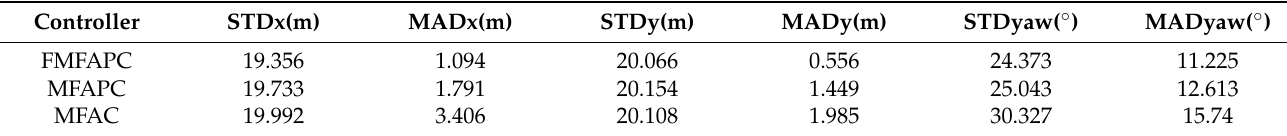
Table 3. STD and MAD of controllers under Scenario 1 .